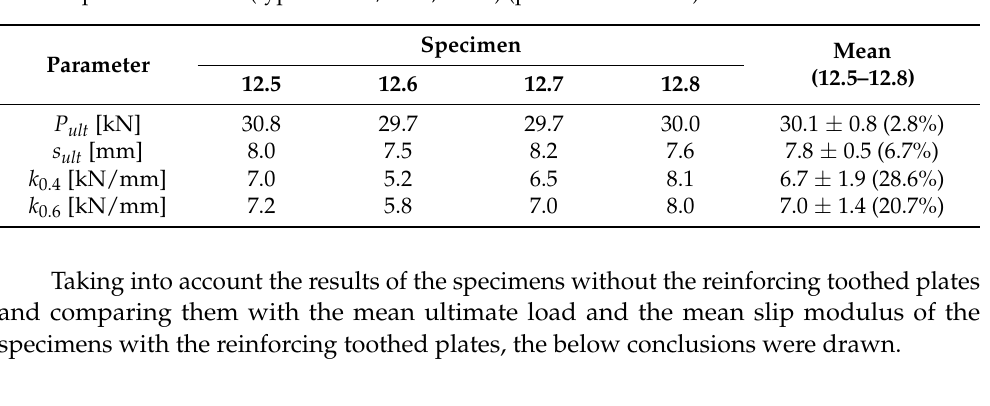
Table 12. The results of the push-out tests of the shear connections with 12 mm screws and with toothed-plate connectors (type C11-50/M12, Geka) (per one